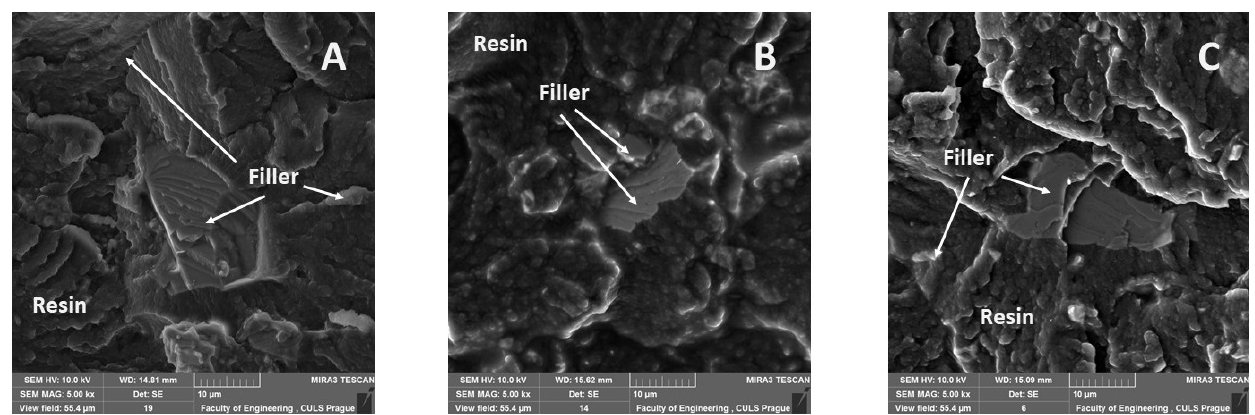
Figure 16. SEM images of fracture surface with filler CaCO 3 calcium carbonate (MAG 5.00 k×): ( A ) mixing speed—460 rpm, ( B ) mixing speed—1700 rpm, ( C ) mixing speed—2500 rpm.